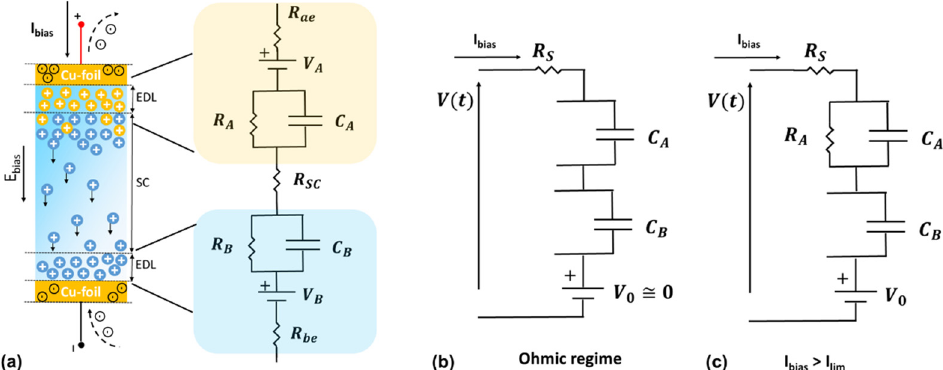
Figure 8. ( a ) Physical representation (from Figure 6b) and the corresponding DC equivalent circuit illustrating the ion accumulation, the electrode potential and the faradaic reactions involved in the device. ( b , c ) Simplified versions of DC circuit for the temperature sensor under current-controlled mode in ohmic regime and with 𝐼 (cid:3029)(cid:3036)(cid:3028)(cid:3046) > 𝐼 (cid:3039)(cid:3036)(cid:3040) , respectively. When a current control signal is applied and the threshold current ( 𝐼 (cid:3039)(cid:3036)(cid:3040) ), at which the